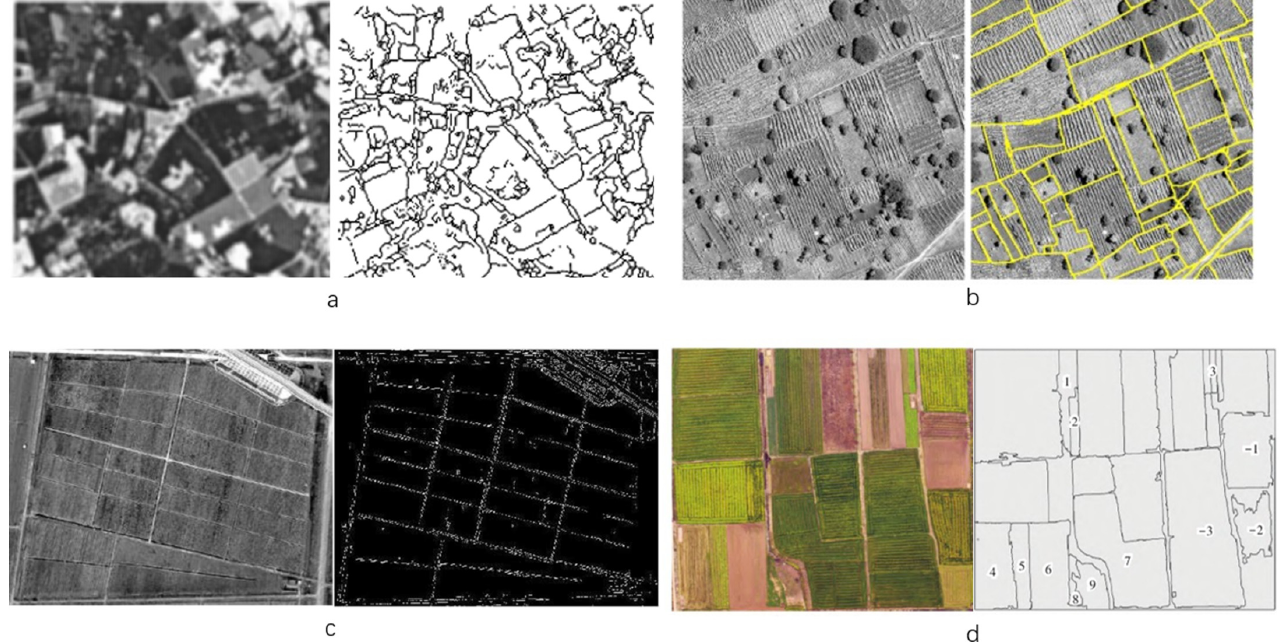
Figure 1. Different forms of farmland boundaries in remote sensing imagery: ( a ) threads in farmland imagery [3]; ( b ) demarcation lines between farmlands [5]; ( c ) boundary objects between farmlands [6]; ( d ) perimeter boundaries of farmland blocks [7] (The number in the picture ( d ) is the number of the farmland).